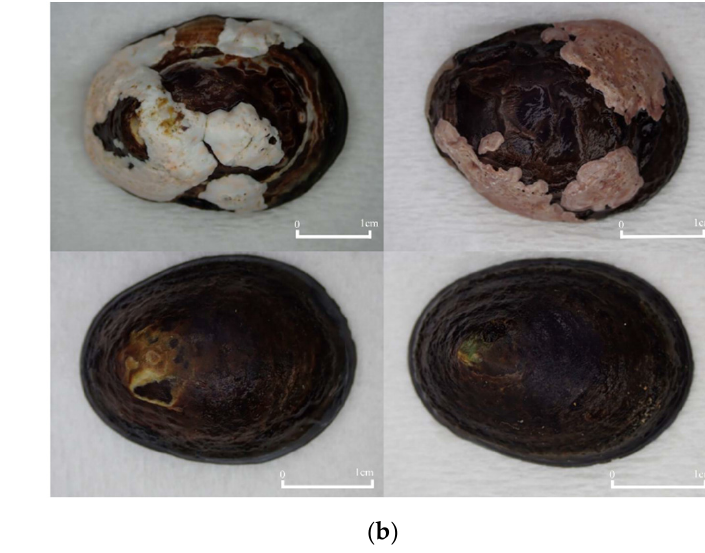
Figure 1. ( a ) The sampling site for Nacella concinna is marked by a white circle (culture experiments) and white triangles (field survey). The insert on the upper left indicates the location of Marian Cove (red square) on King George Island. ( b ) Sample images of N. concinna were used in this study. The upper row shows N. concinna partially covered by the coralline algae Clathromorphum obtectulum . The lower row shows N. concinna without C. obtectulum on the